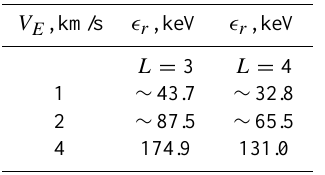
Fig. 2. Schematics of the equatorial projection of the Polarization Jet band inclined to lines B eq = const at a small angle α 0 (not to scale). Arrows within the band show gradient drift velocity for ions, V i gr (westward), and for electrons, V e gr (eastward), and the common westward convection velocity V C . Due to their gradient drift, energetic ions enter the band through its equatorial border, while electrons - through the polar